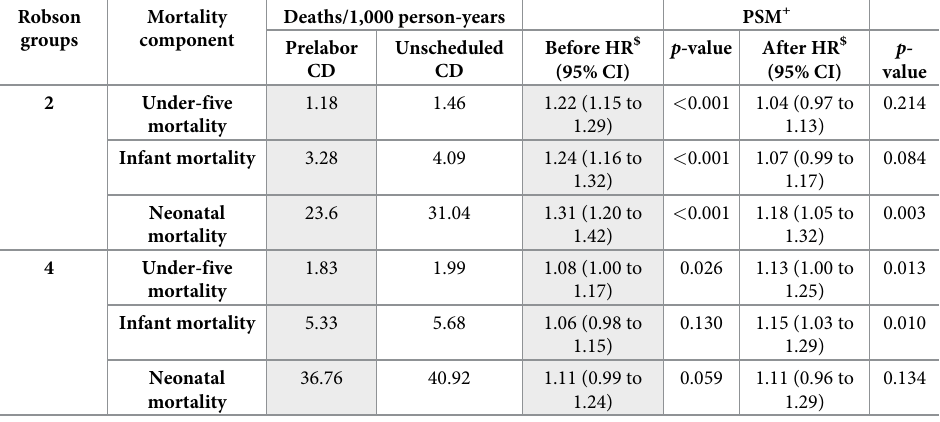
Table 4. Under-five, infant, and neonatal mortality in planned CD groups (2b and 4b) compared with unsched- uled CD group 2a and 4a, Brazil (2012 to 2018). Robson